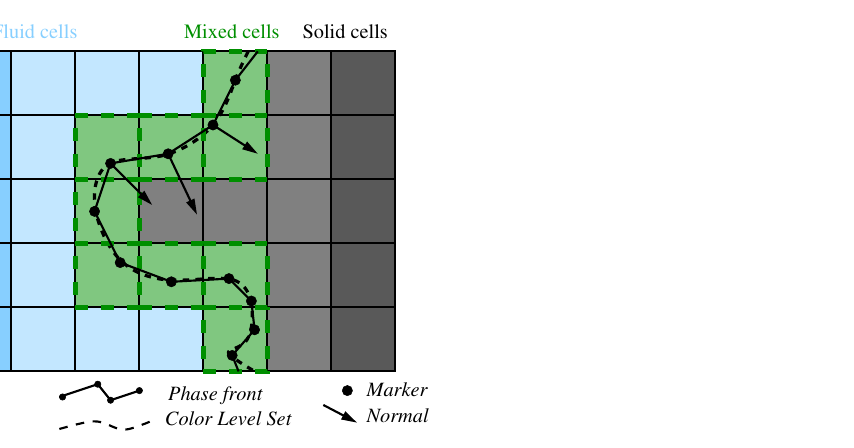
Figure 3. Illustration of the mesh and phase front. The color Level-Set is in dashed black line, the phase front mesh in solid black line, the markers are the bullets. Fluid cells are in blue, solid ones in gray and mixed ones in